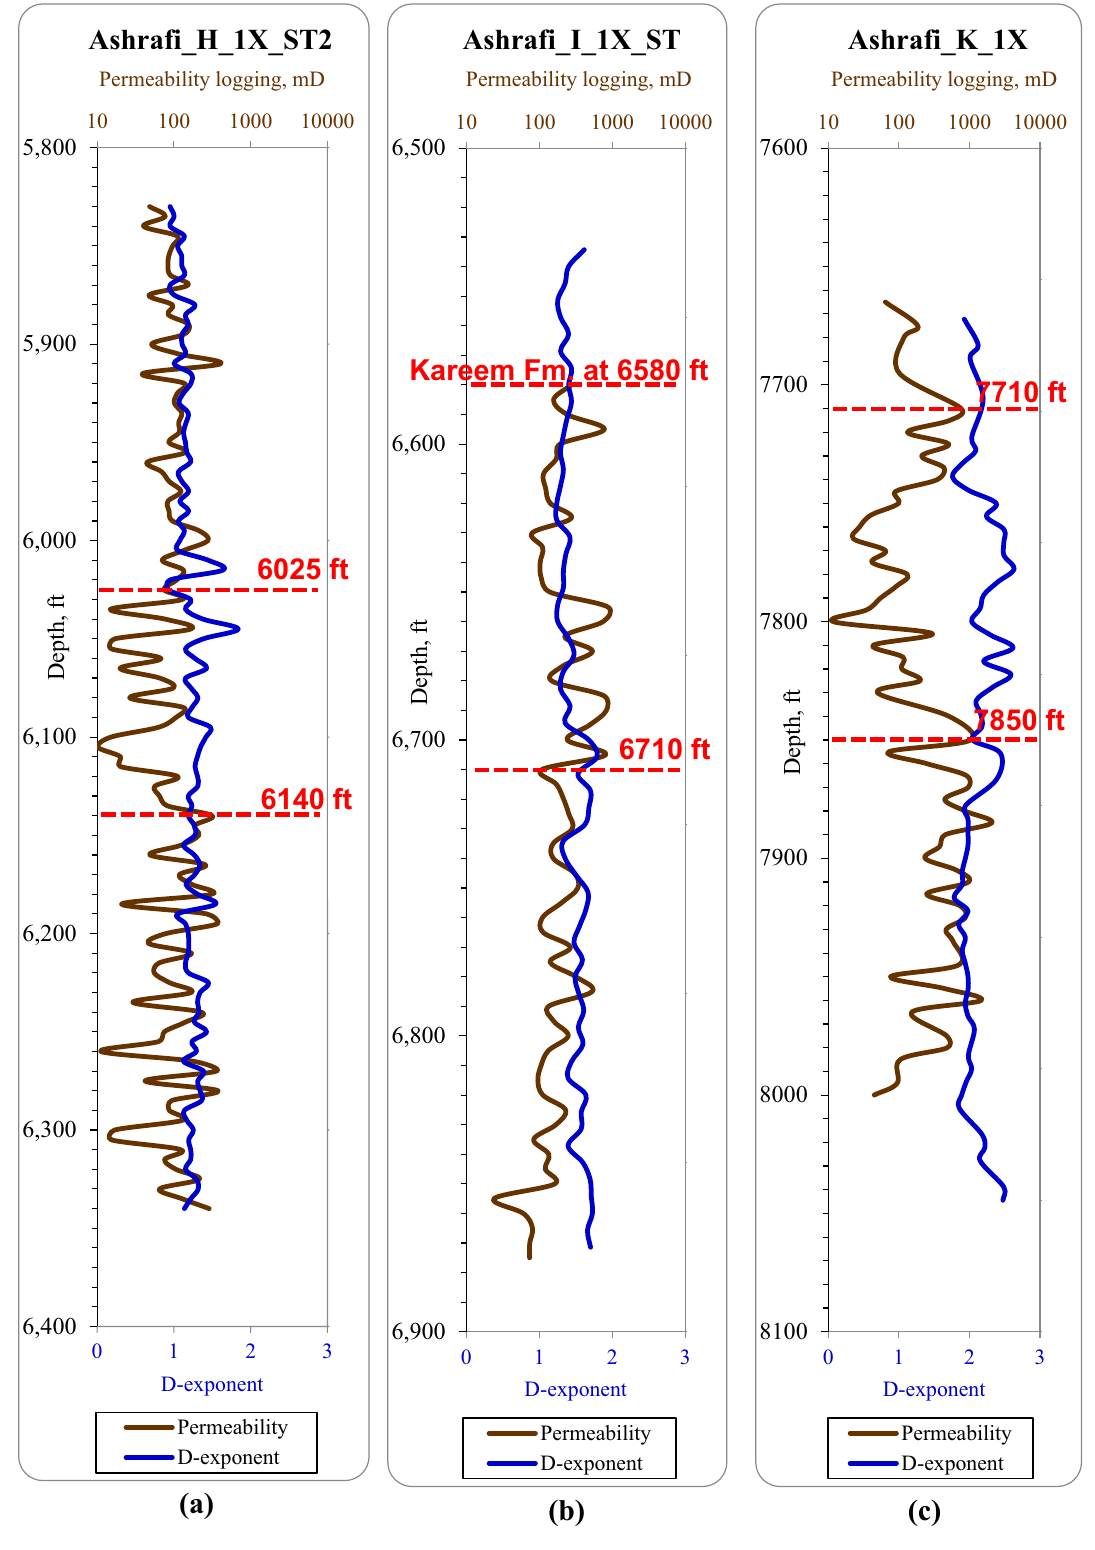
Fig. 7 D -exponent and permeability log with depth relationship. a Ashrafi_H_1X_ST2, b Ashrafi_I_1X_ ST, and c Ashrafi_K_1X. The red dashed lines represent the possible overpressure